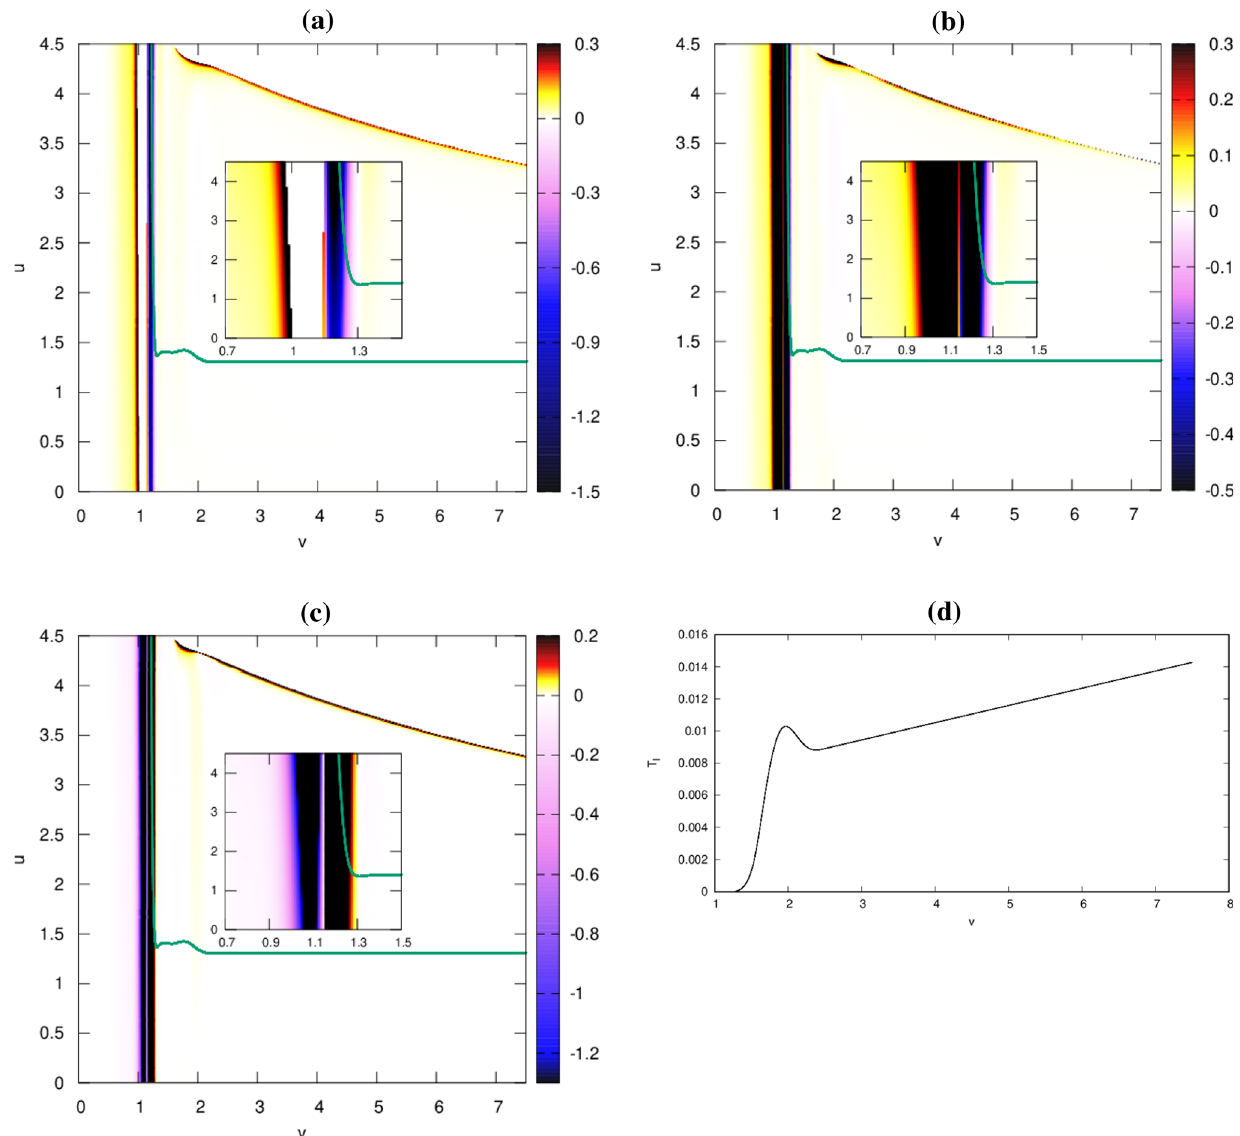
Fig. 15 The (v u ) -distribution of a energy density, ˆ ρ , b radial pres- sure, ˆ p r , and c pressure anisotropy, ˆ p a , and d local temperature along the black hole apparent horizon, T l , as a function of advanced time for